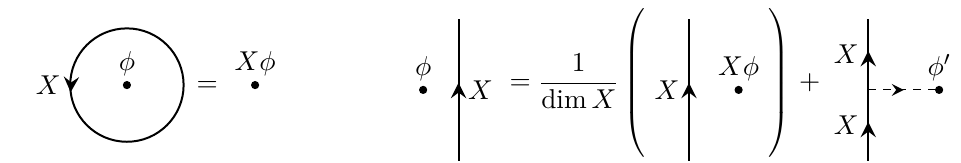
Figure 2 . On the left, a topological defect line X encircles a φ insertion in the plane. Since the line is topological, this is equivalent instead to the local operator Xφ . On the right, a topological defect line X sweeps past the φ insertion leaving behind a local operator and a defect operator φ 0